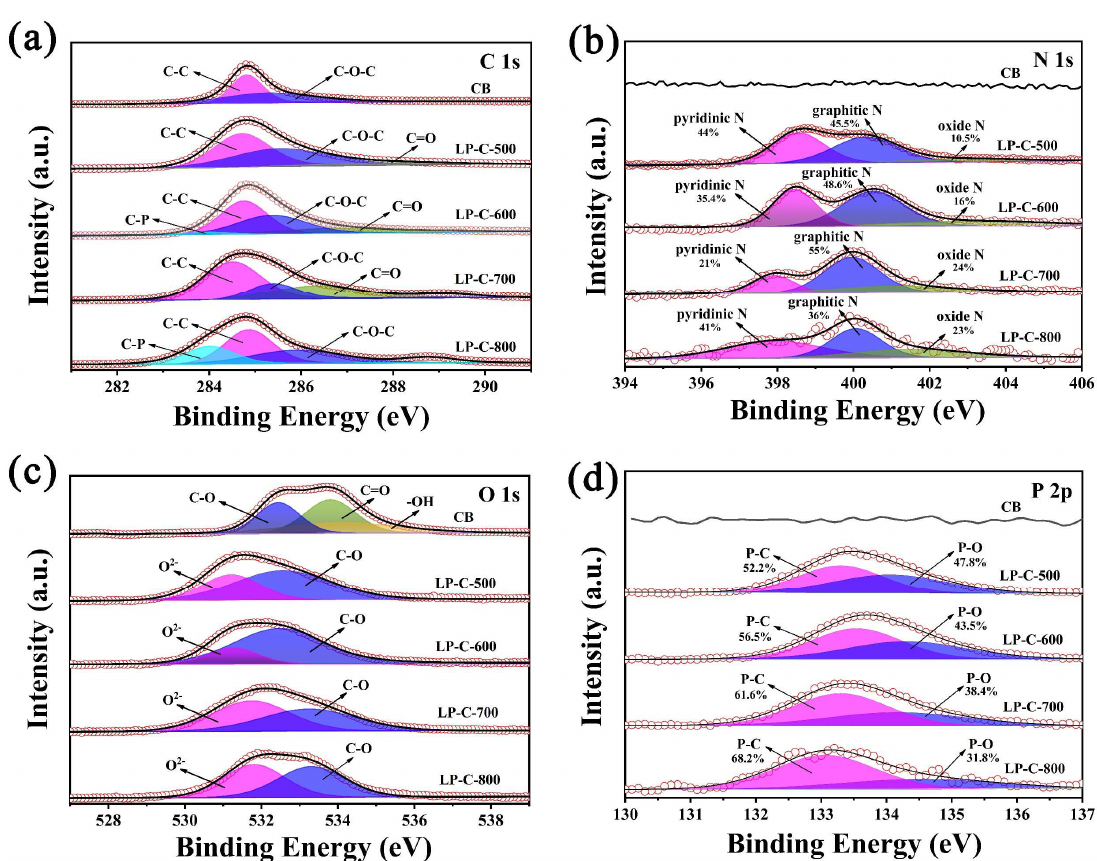
Figure 5. High-resolution XPS spectra of ( a ) C 1s, ( b ) N 1s, ( c ) O 1s, and ( d ) P 2p of samples.